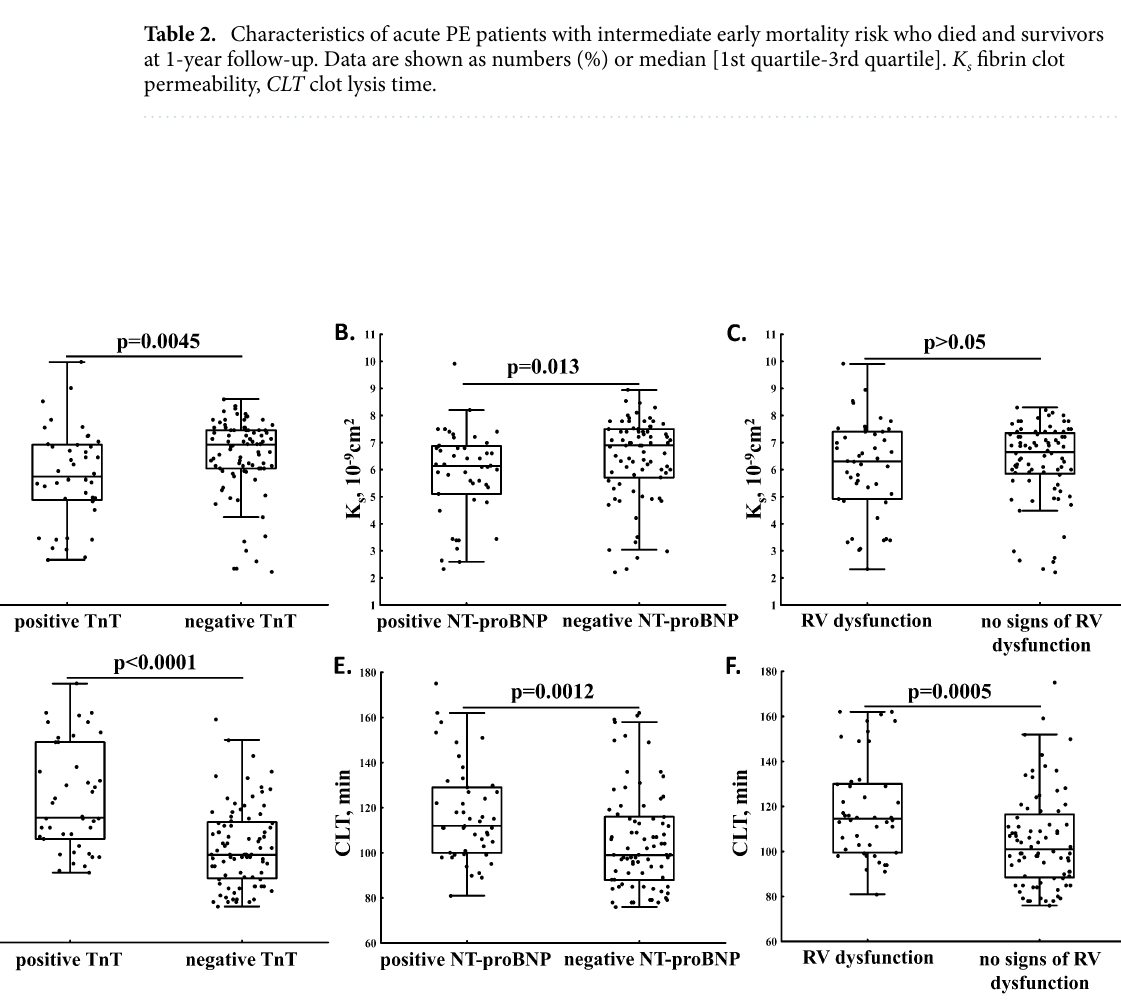
Figure 2. Fibrin clot permeability (K s ) and clot lysis time (CLT) in acute PE patients with positive vs. negative TnT ( A , D ) and NT-proBNP ( B , E ) and with or without right ventricular (RV) dysfunction ( C , F